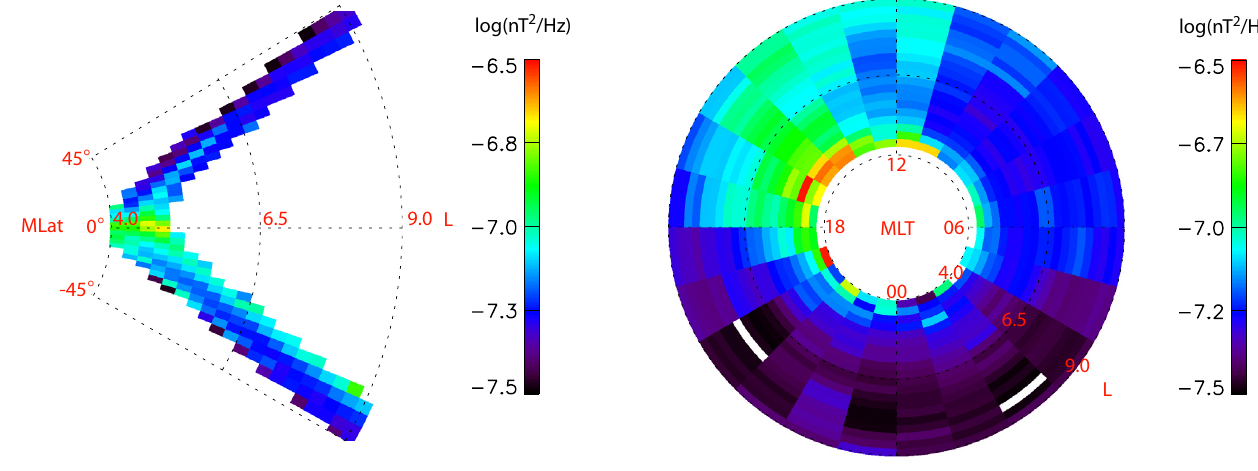
Fig. 1. Distribution of the spectral density in the frequency range 0 . 0005 ≤ f/f ce < 0 . 02 dominated by magnetosonic waves.